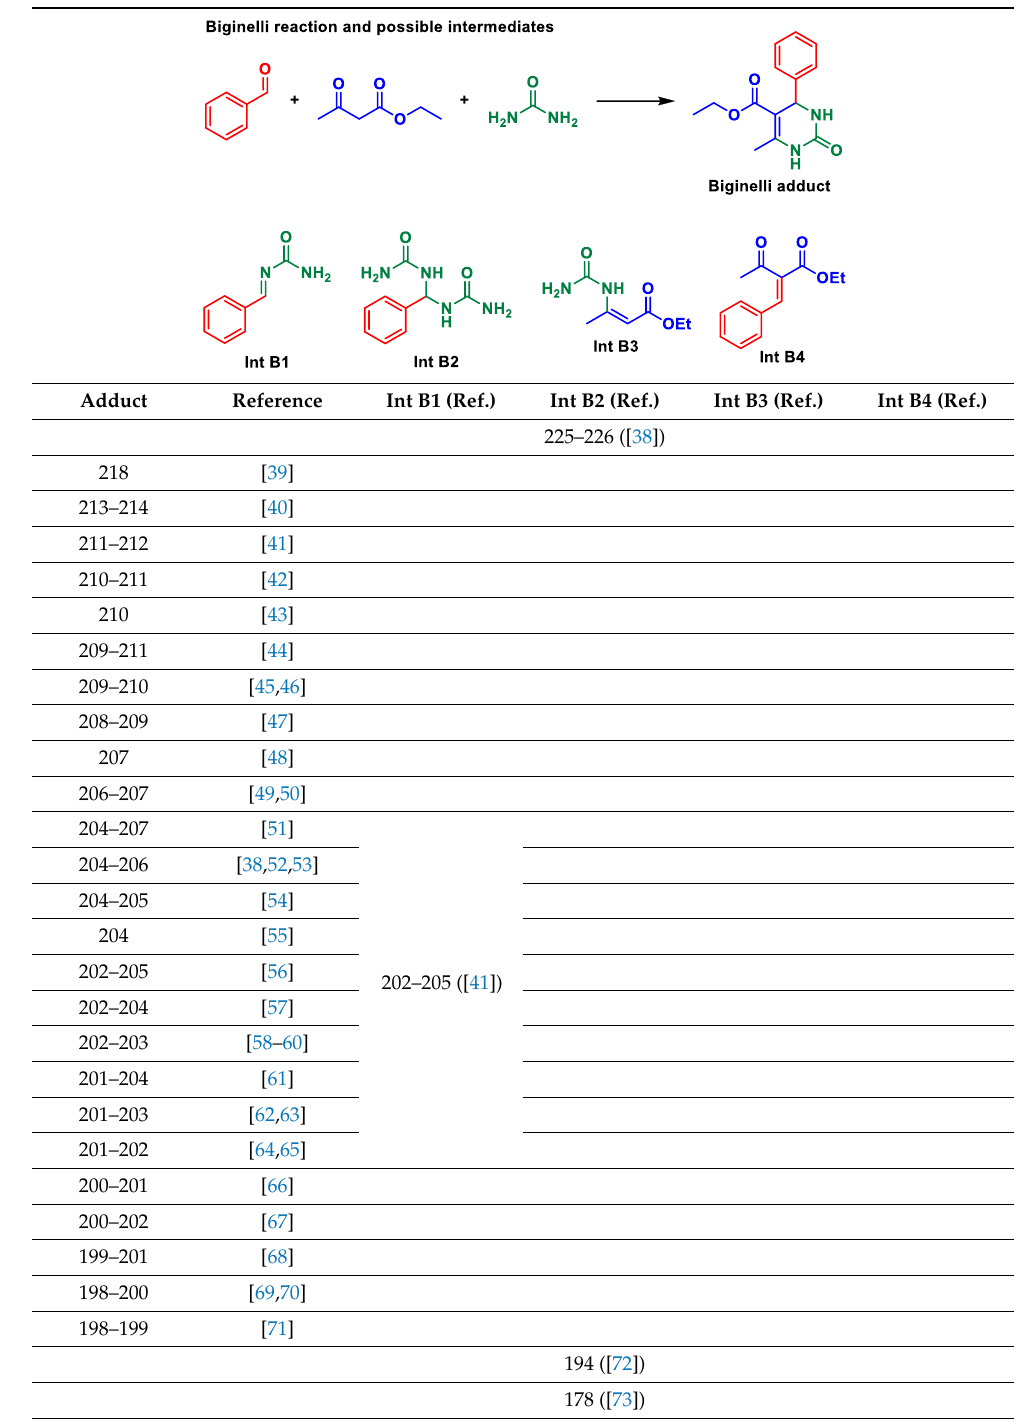
Table 1. Reported mps (°C) for 4 common Biginelli reaction intermediates and for the MCR adduct (DHPM) typically formed in the model reaction.